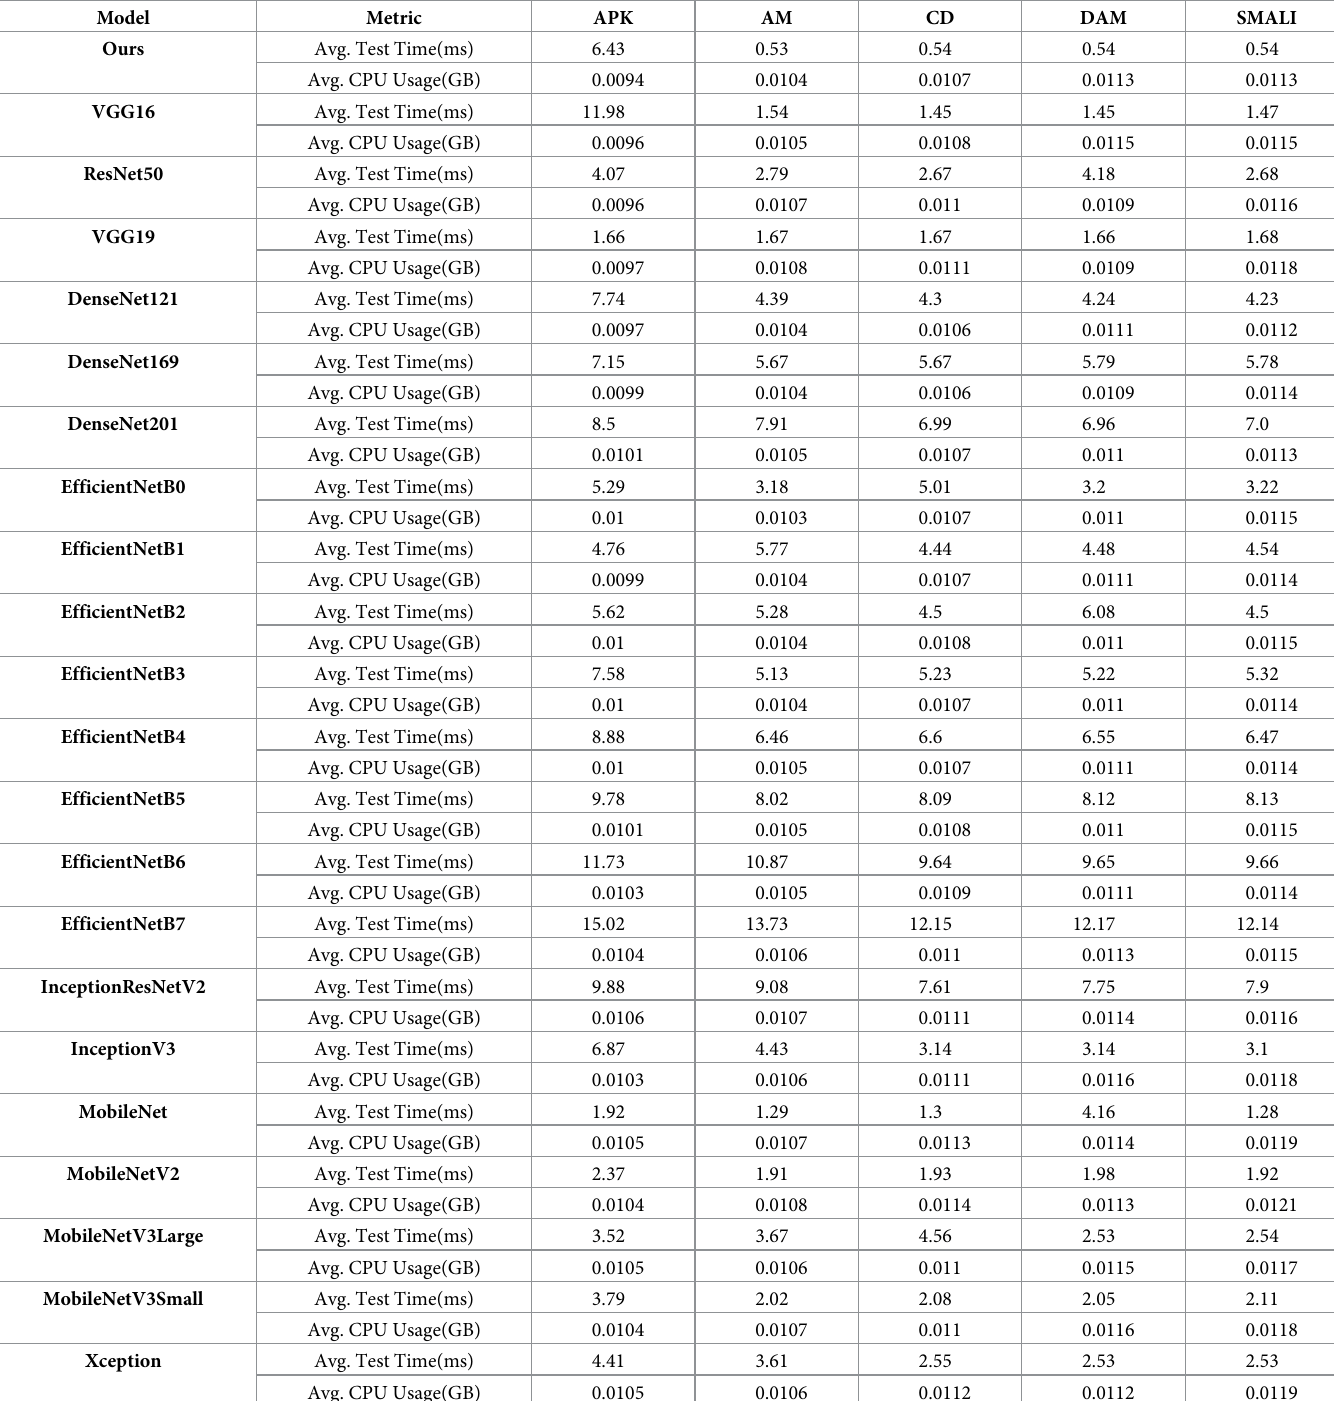
Table 8. Complexity performance of models on DREBIN